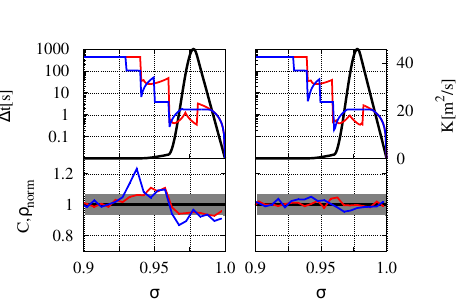
Figure 7. Experiments with the sampled “average” diffusivity dis- Fig. 7. Experiments with the sampled ‘average’ diffusivity distri- tribution for the interpolation algorithms D (blue), D 0 (green) and A bution for the interpolation algorithms D (blue), D ′ (green) and A (red). Top panel: Diffusivity profile as interpolated by A (black) and (red). Top panel: diffusivity profile as interpolated by A (black) and Table 2. Execution time and RMSE for experiments made with ∆ t profiles for the different interpolation settings. Bottom panel: 1t profiles for the different interpolation settings. Bottom panel: the sampled ‘averaged’ diffusivity distribution, varying interpola- Normalized final concentration and expected distribution (black). normalised final concentration and expected distribution (black). tion method.